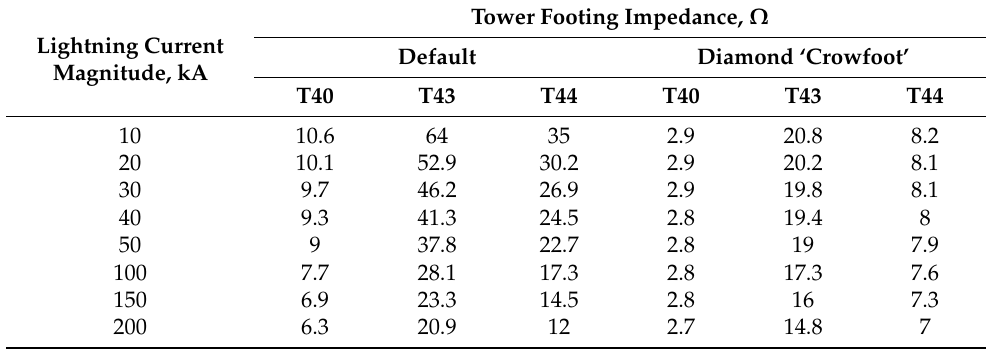
Table 8. Tower footing impedance value for amplitude current variation before and after improvement.